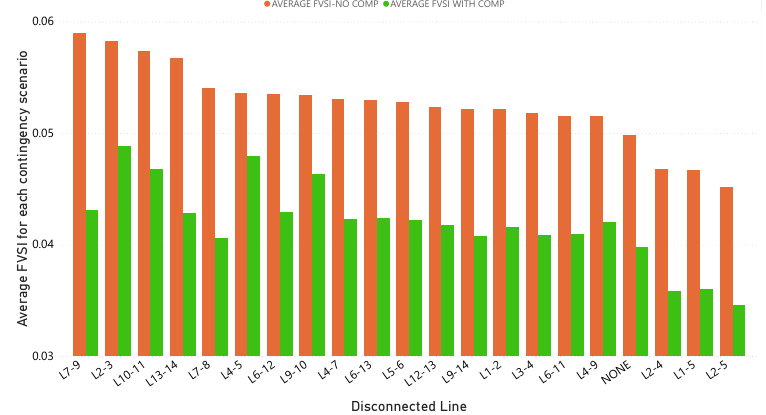
Figure 5. Fourteen-bus-bar system: statistical analysis for every contingency scenario with optimal compensation.